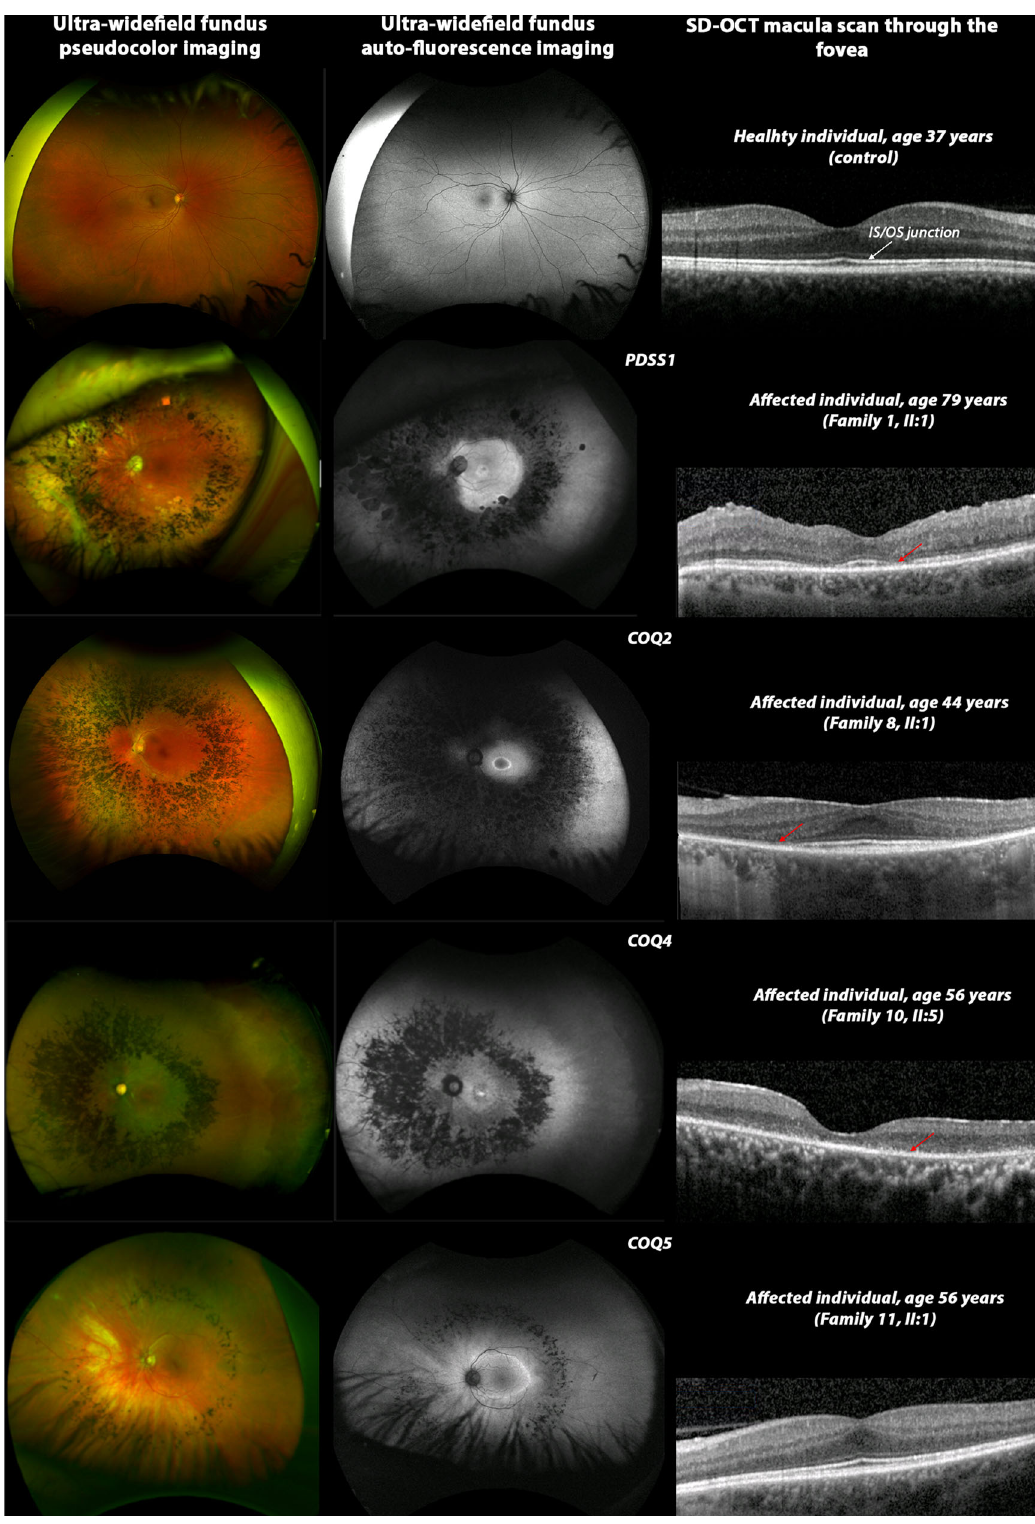
Fig. 2 Multimodal imaging composite of control (right eye only) and four affected individuals (left eye only) carrying candidate pathogenic variants in PDSS1 , COQ2 , COQ4 and COQ5 . Ultra-wide fi eld fundus pseudocolor imaging shows characteristic features of retinitis pigmentosa: retinal vessels attenuation, pigmentary (bone spicule) changes in mid-periphery. Ultra-wide fi eld fundus auto- fl uorescence image demonstrates hypoauto fl uorescence corresponding to mid-peripheral bone spicules with a hyperauto fl uorescence ring at the macula delineating the border between normal (inside the ring) and abnormal retina (outside the ring). SD-OCT macula scan through the fovea shows absence of inner segment/outer segment (IS/OS) junction (red arrow) in the parafoveal region in affected individuals carrying candidate pathogenic variants in PDSS1 , COQ2 and COQ5 . Absence of IS/OS junction in the fovea and parafoveal region in affected individual from family 10,